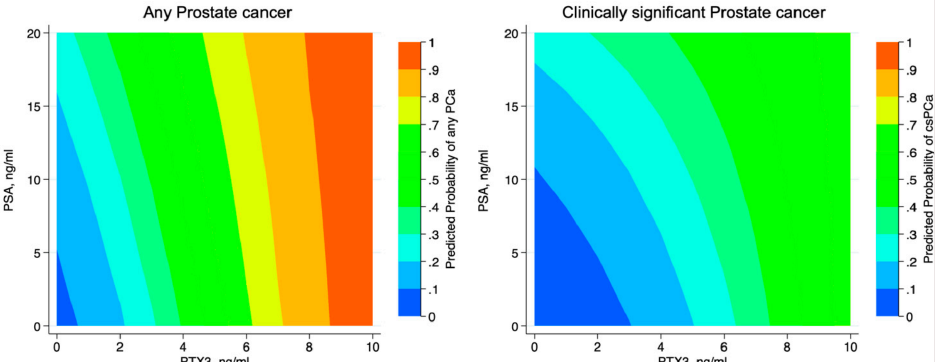
Figure 2. Contour plot showing the predicted probability of anyPCa and csPCa in patients undergo- ing prostate biopsy according to PSA and PTX3. For PSA values below 10 ng/mL, PTX3 is able to better discriminate presence of anyPCa and